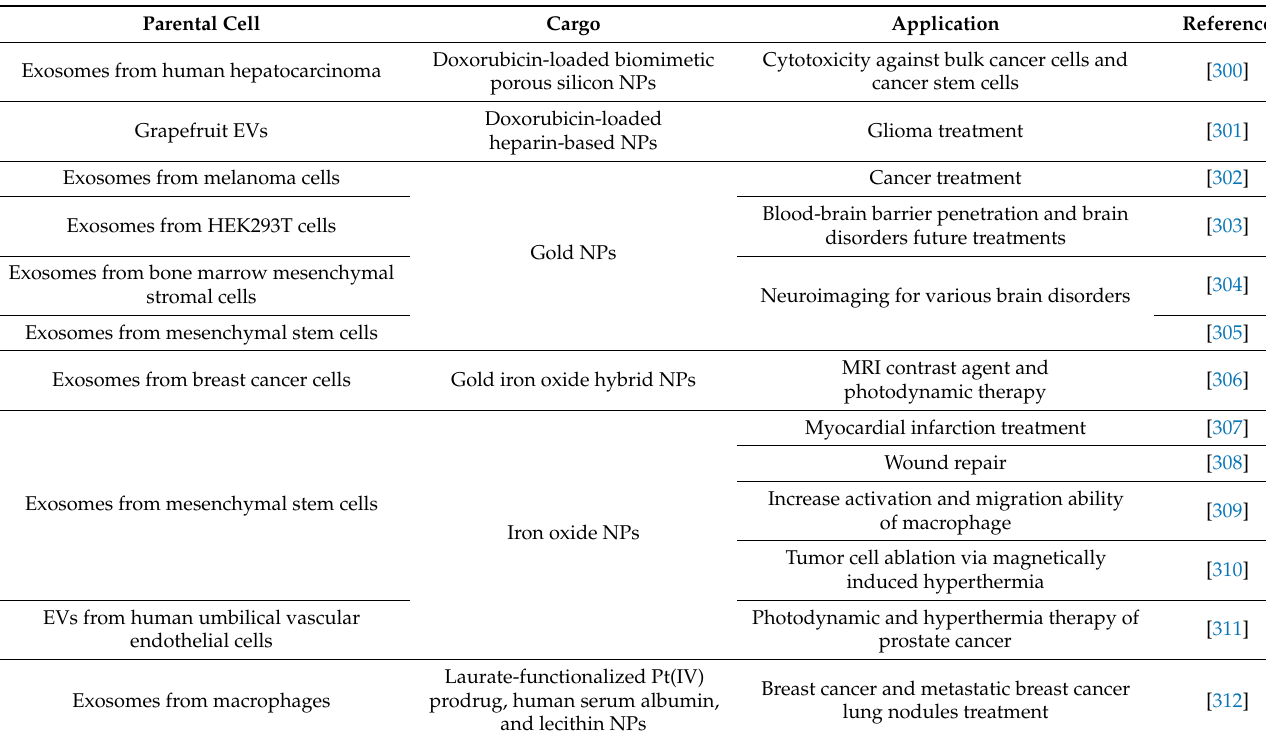
Table 10. Extracellular vesicles’ inorganic NPs delivery